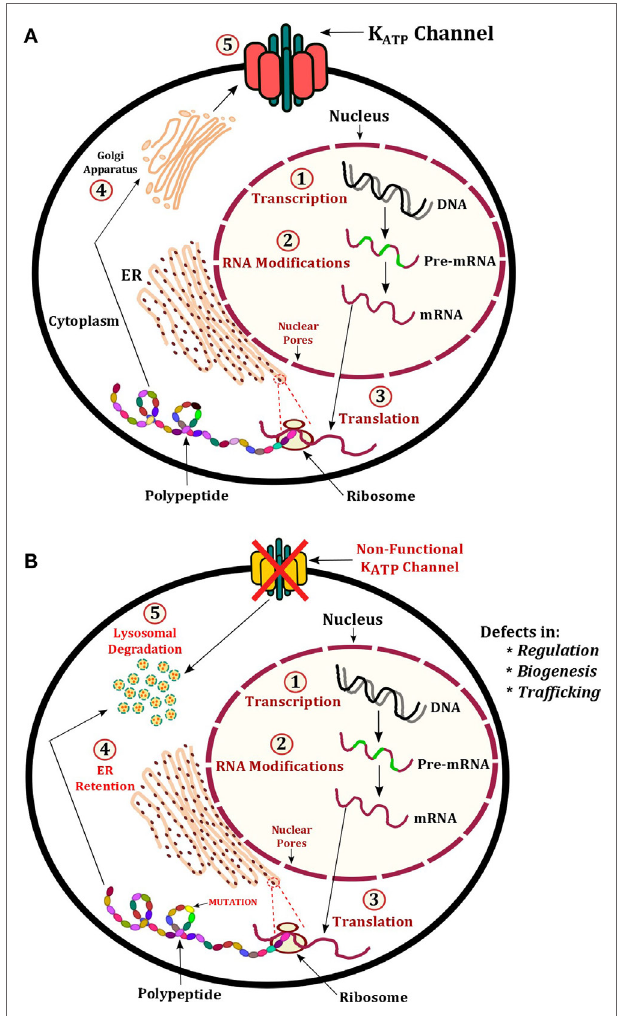
FiGURe 3 | illustration of K ATP channel protein production and regulation . (A) Normal production of K ATP channels involves transcription of ABCC8 and KCNJ11 to produce pre-mRNA, this undergoes modification to become mature mRNA. The mRNA exits the nucleus and is translated into a protein on ribosomes embedded on the ER. The polypeptide(s) fold into the tertiary structure and enter the Golgi apparatus for post-translational modifications. Vesicles containing the fully assembled K ATP channel proteins are then expressed at the membrane. (B) Mechanisms of CHI include defects in regulation, biogenesis, and trafficking. In these cases, the defective K ATP channel may undergo protein degradation in